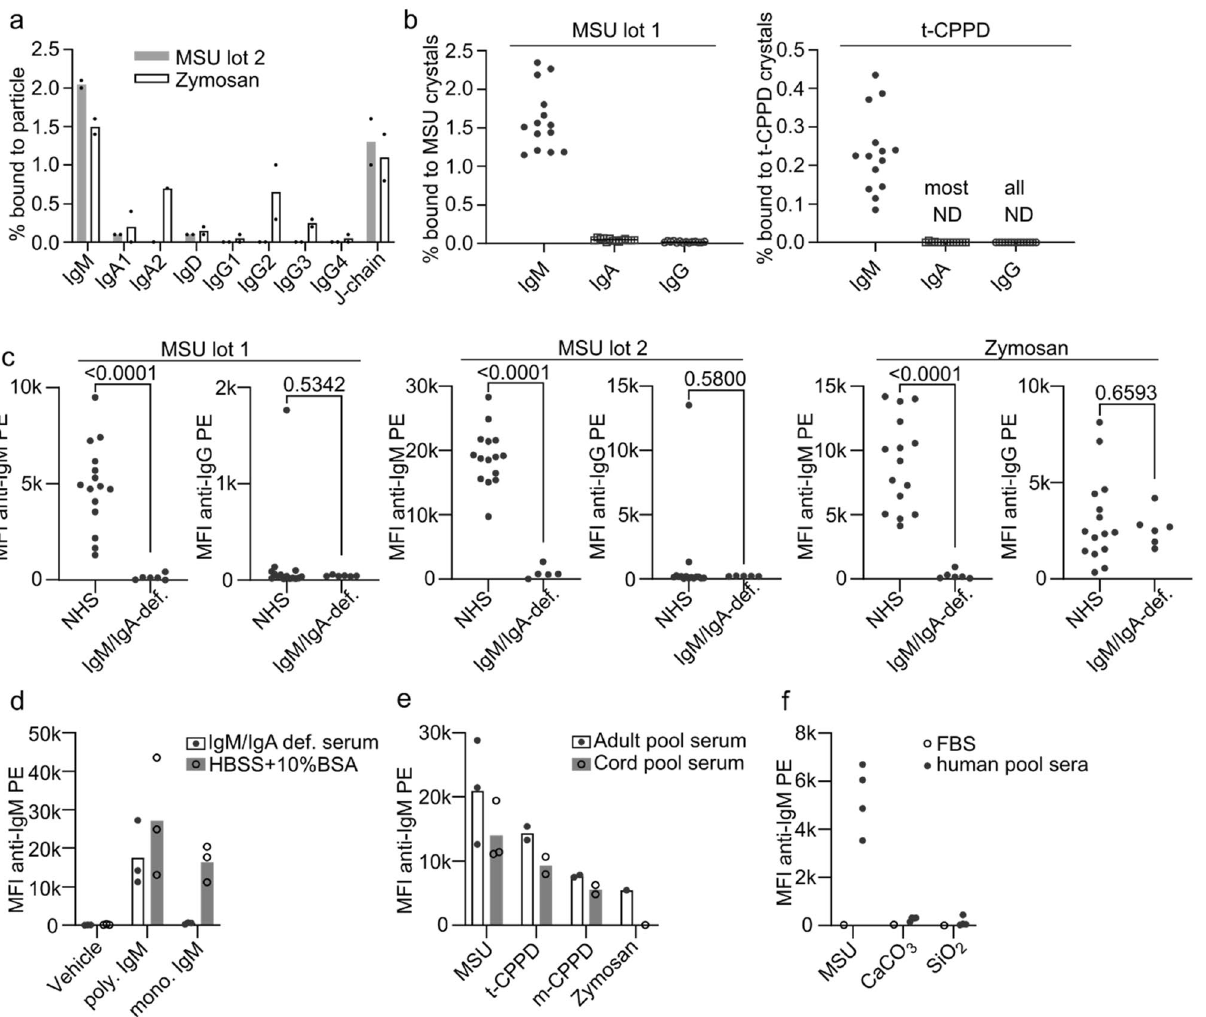
Figure 1. Natural IgM binds to MSU and CPPD crystals. ( a ) Serum proteins bound to each indicated particle were analyzed by LC–MS. Fraction of each antibody isotype bound to each indicated particle is shown. Data from 2 individual serum samples is depicted. In one serum sample, IgA2 was not detected; therefore, only one data point is shown. ( b ) Fraction of immunoglobulin isotypes bound to MSU or t-CPPD crystals from 14 normal human serum samples quantified from Western blot analysis. ND = not detected. Raw data (blot images) is shown in Supplementary Fig. 1. ( c ) Individual normal human sera (NHS, including samples from B) or IgM/IgA-deficient serum samples were incubated with the indicated particles, and bound IgM and IgG were detected using anti-IgM PE or anti-IgG PE, respectively. Median fluorescence intensity (MFI) of the particles was normalized by subtracting the MFI of the negative control (FBS). Means of the NHS and IgM/IgA-deficient serum samples were compared by an unpaired t-test. ( d ) Binding of purified polyclonal (poly.) or monoclonal (mono.) IgM to three distinct preparations of MSU crystals in IgM/IgA-def. serum or HBSS + 10% BSA. ( e ) Pooled human serum collected either from healthy adults or from human cord blood was incubated with the indicated particles, and bound IgM was detected as in (c). Values for each particle preparation and the mean are shown. ( f ) MSU (lot 2), silica (SiO 2 ), or calcium carbonate (CaCO 3 ) crystals were incubated in FBS or 4 normal human pool serum samples. Bound human IgM was detected as in (c) and MFI for each serum sample is shown including the negative controls